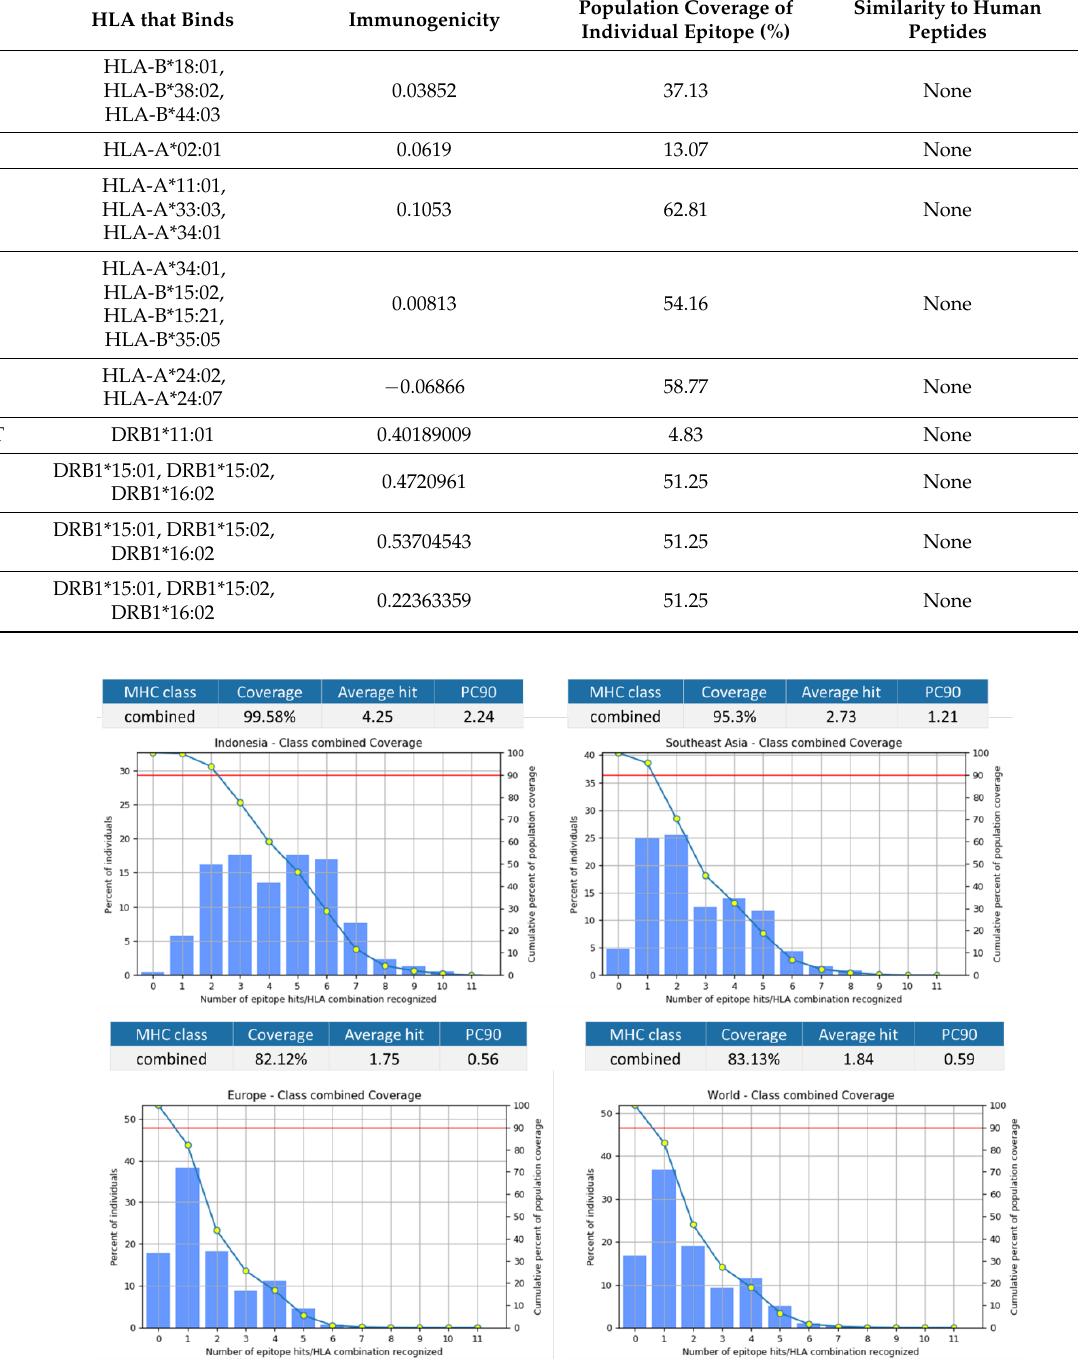
Table 13. Potential epitopes for universal vaccine construct. Listed are epitopes that are fully conserved across the coronavirus family and epitopes with identical TCR contact residue across SARS-CoV-2 and Human CCCs. Each of these epitopes was not similar to the human peptides. Population Coverage of Similarity to Human HLA that Binds Immunogenicity Individual Epitope (%) Peptides